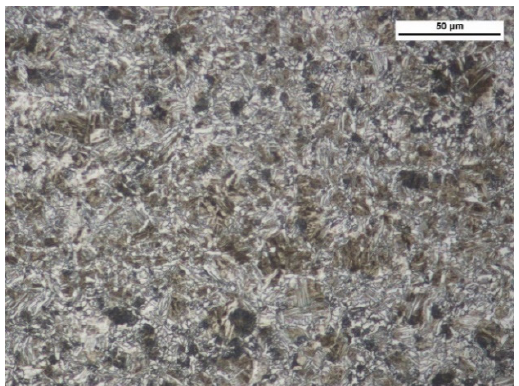
Figure 3. XAR 600 steel microstructure—tempered martensite. Magnitude ×500, etched with 3% HNO 3 (Mi1Fe), scanning microscopy.